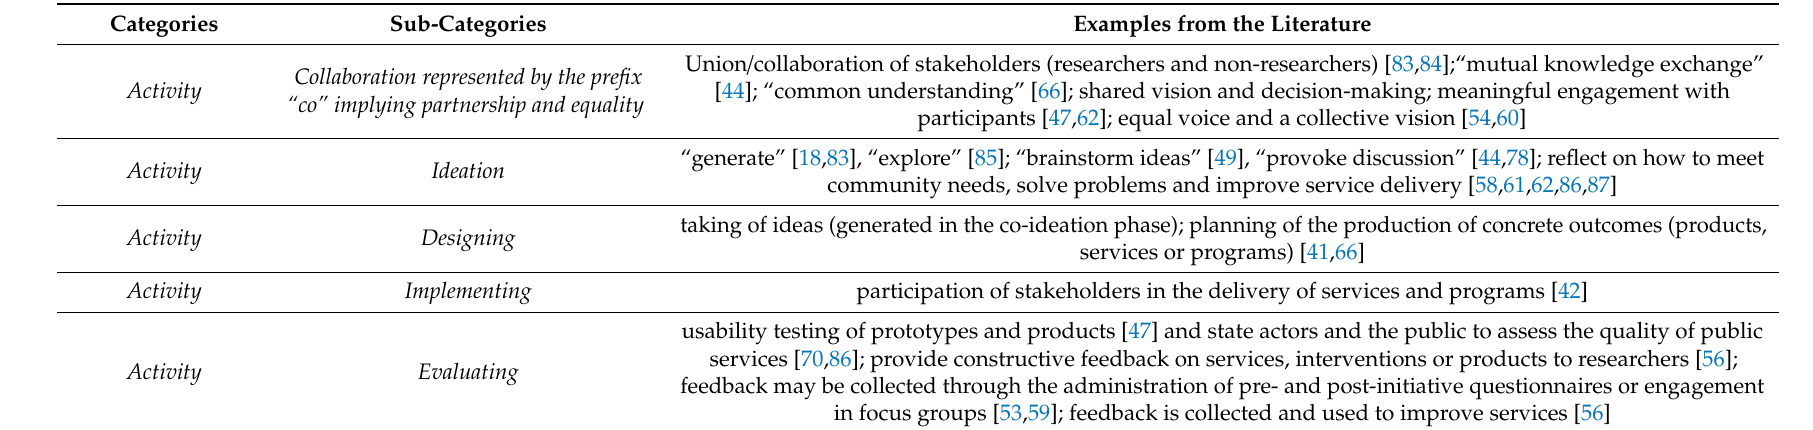
Table 3. Examples of latent and manifest content used to inform a new definition of “Co-Creation of